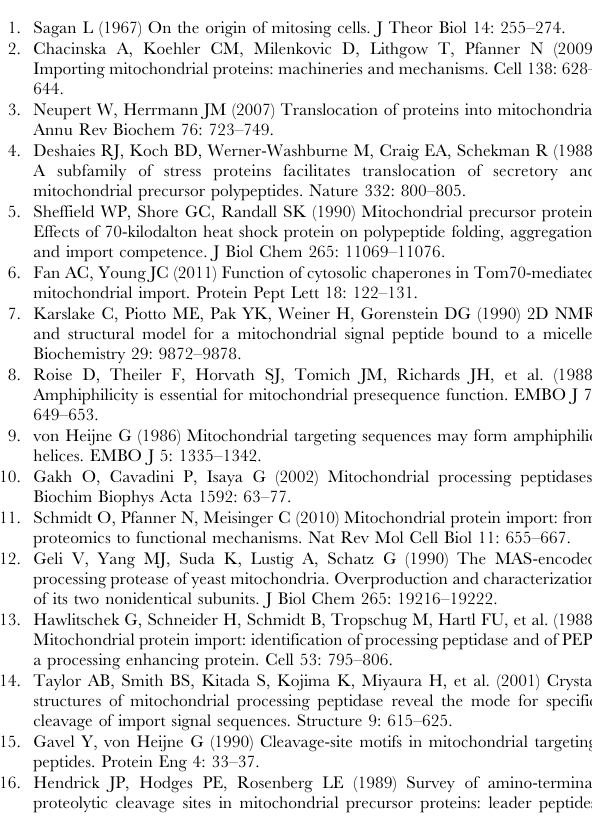
unprocessed protein, while the lower band corresponds to the processed protein. (TIF) Figure S5 Clustered lysine residues are important for mitochondrial targeting in mammalian cells. (A) HEK293T cells transfected with pEGFP–NTS D I2 K2A, (B) pEGFP–NTS D I2 K5A, (C) pEGFP–NTS D I2 K7A, (D) pEGFP–NTS D I2 K38A–K40A and (E) pEGFP–NTS D I2 K29A–K61A are shown. Cells were live-stained with Mitotracker Alexa 633 and subsequently fixed. Scale bars, 10 m m. (TIF) Figure S6 Immuno-blot of HEK293T cells. Whole cell lysates from untransfected cells, cells producing EGFP, and cells producing EGFP fused to NTS D I2, NTS D I2–K2A, NTS D I2– K5A, NTS D I2–K7A, NTS D I2–K29A–K61A, and NTS D I2– K38A–K40A are shown.